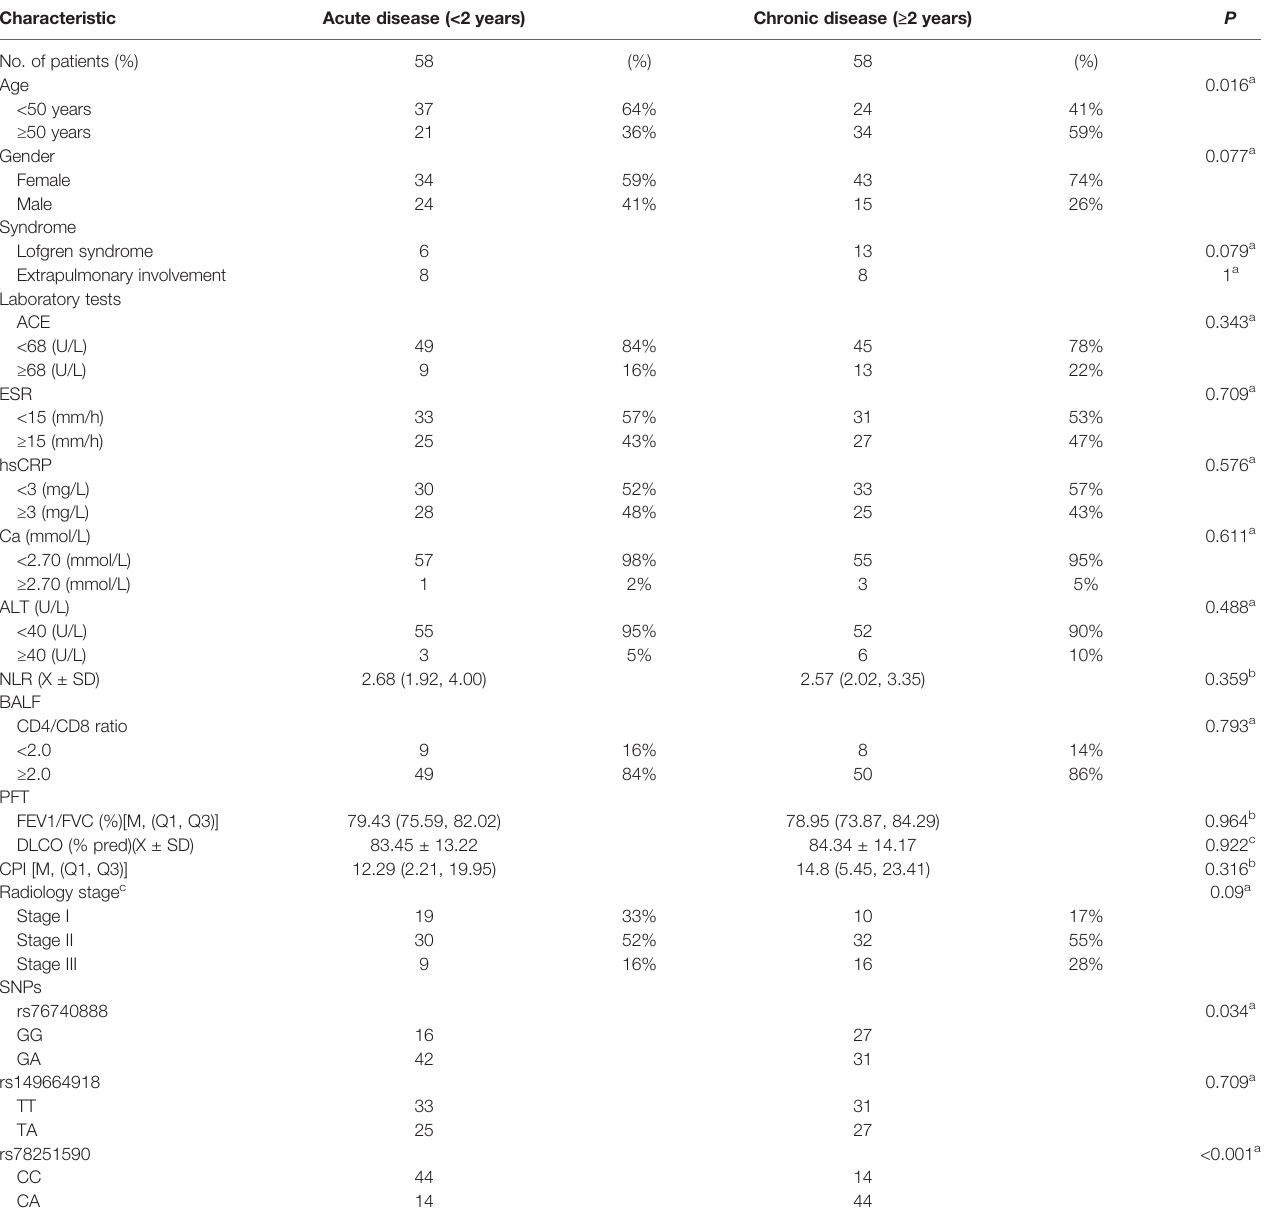
TABLE 3 | Univariate analysis of three missense mutations and clinical characteristics of 116 sarcoidosis patients.